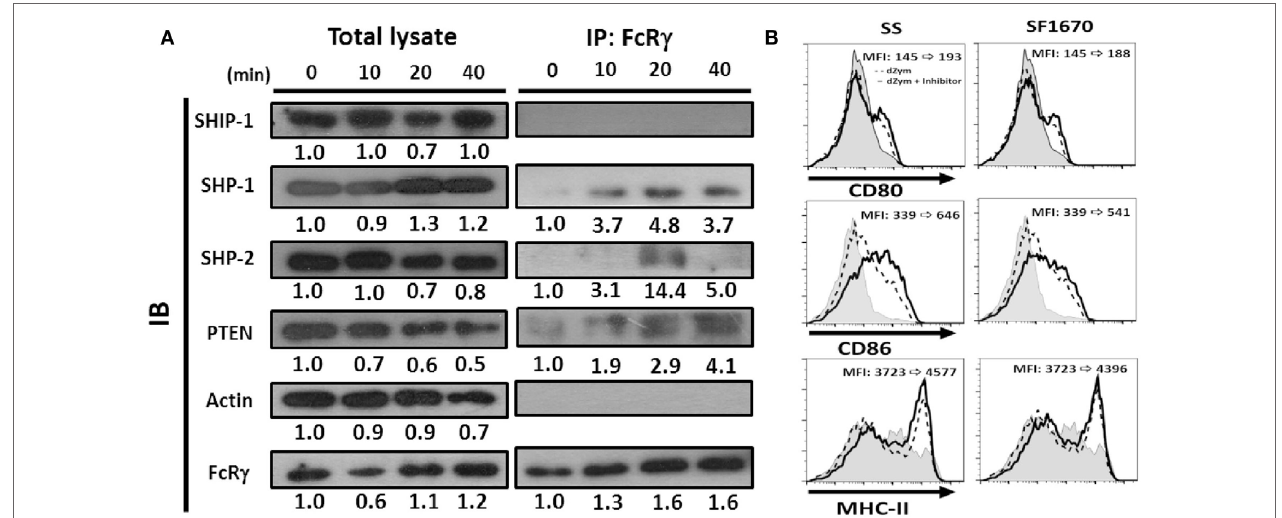
FigUre 8 | Phosphatases were recruited by FcR γ and negatively regulated Dectin-1 responses in DCs. Six-day-cultured BMDCs derived from WT mice were collected and treated with dZym. (a) Cell lysates were collected at indicated time points and incubated with anti-FcR γ Ab. After 16 h, protein A/G beads were added for precipitation. The phosphatases SHIP-1, SHP-1, SHP-2, and PTEN in whole cell lysate or associated proteins with FcR γ were detected by SDS-PAGE and Western blot. Quantification was determined by densitometry using ImageJ software. (B) BMDCs were incubated with sodium stibogluconate (SS) (SHP-1 inhibitor) or SF1670 (PTEN inhibitor) for 1 h before dZym treatment. After 16 h, the expressions of CD80, CD86, and MHC-II were detected by flow cytometry. The changes of MFIs from control to treatment are indicated in each histogram. Gray areas represented the isotype-matched Ig controls. All data shown were representative from three to five independent